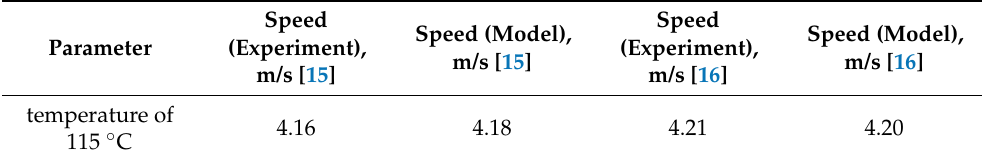
Table 8. Comparison of the authors’ experimental data and simulation results [15,16] at the tempera- ture of 115 ◦